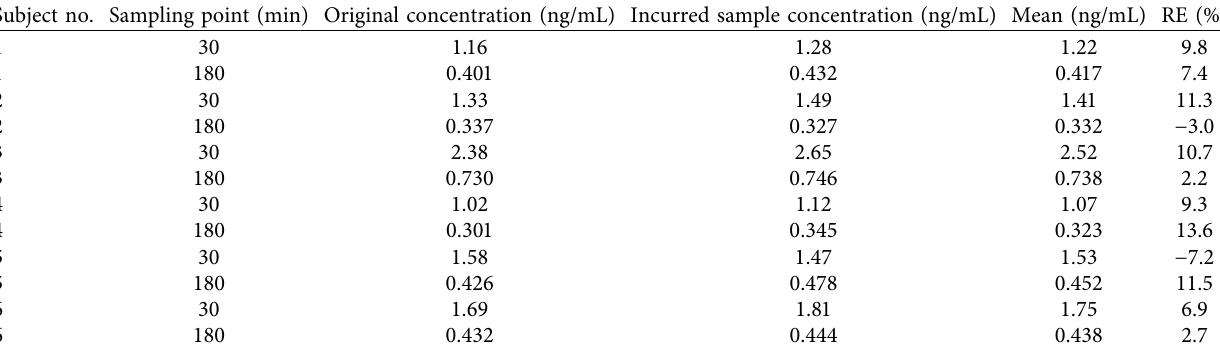
Table 2: Incurred sample reanalysis data of